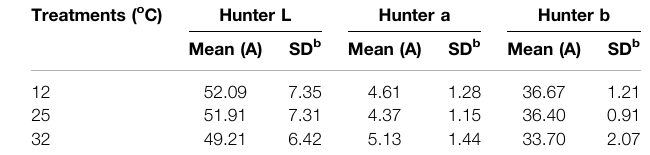
TABLE 6 | Color of whole stillage over time. a